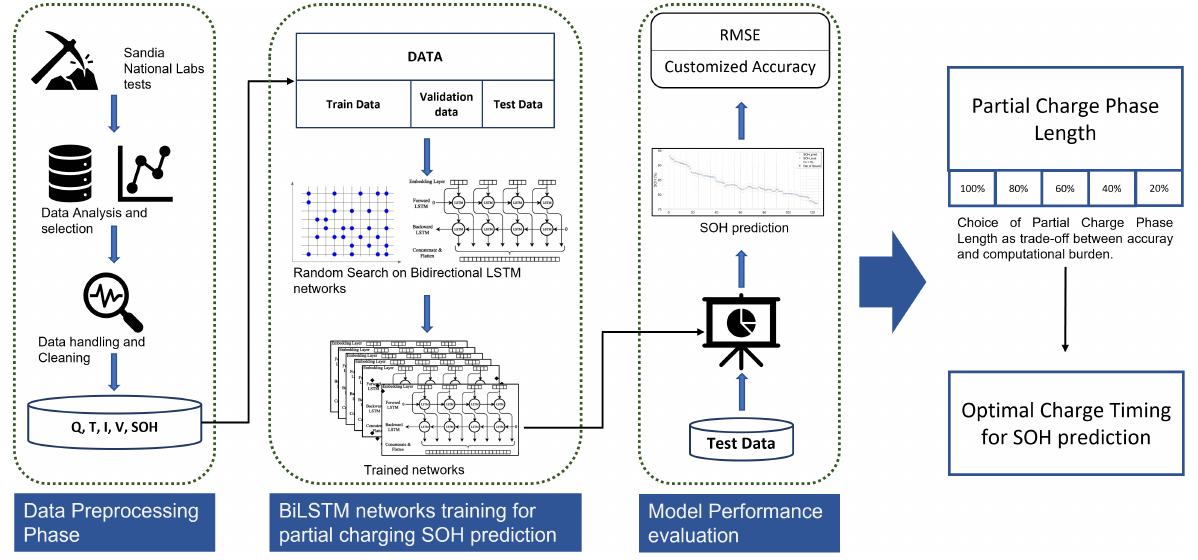
Figure 1. The proposed methodology for battery SOH prediction during partial charging